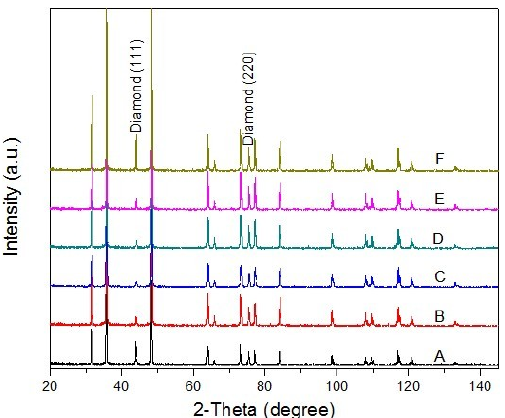
Figure 2. XRD patterns of diamond deposited using different silicon concentrations. A: 0 atom %; B: 0.11 atom %; C: 0.52 atom %; D: 0.98 atom %; E: 1.41 atom % and F: 1.81 atom %.